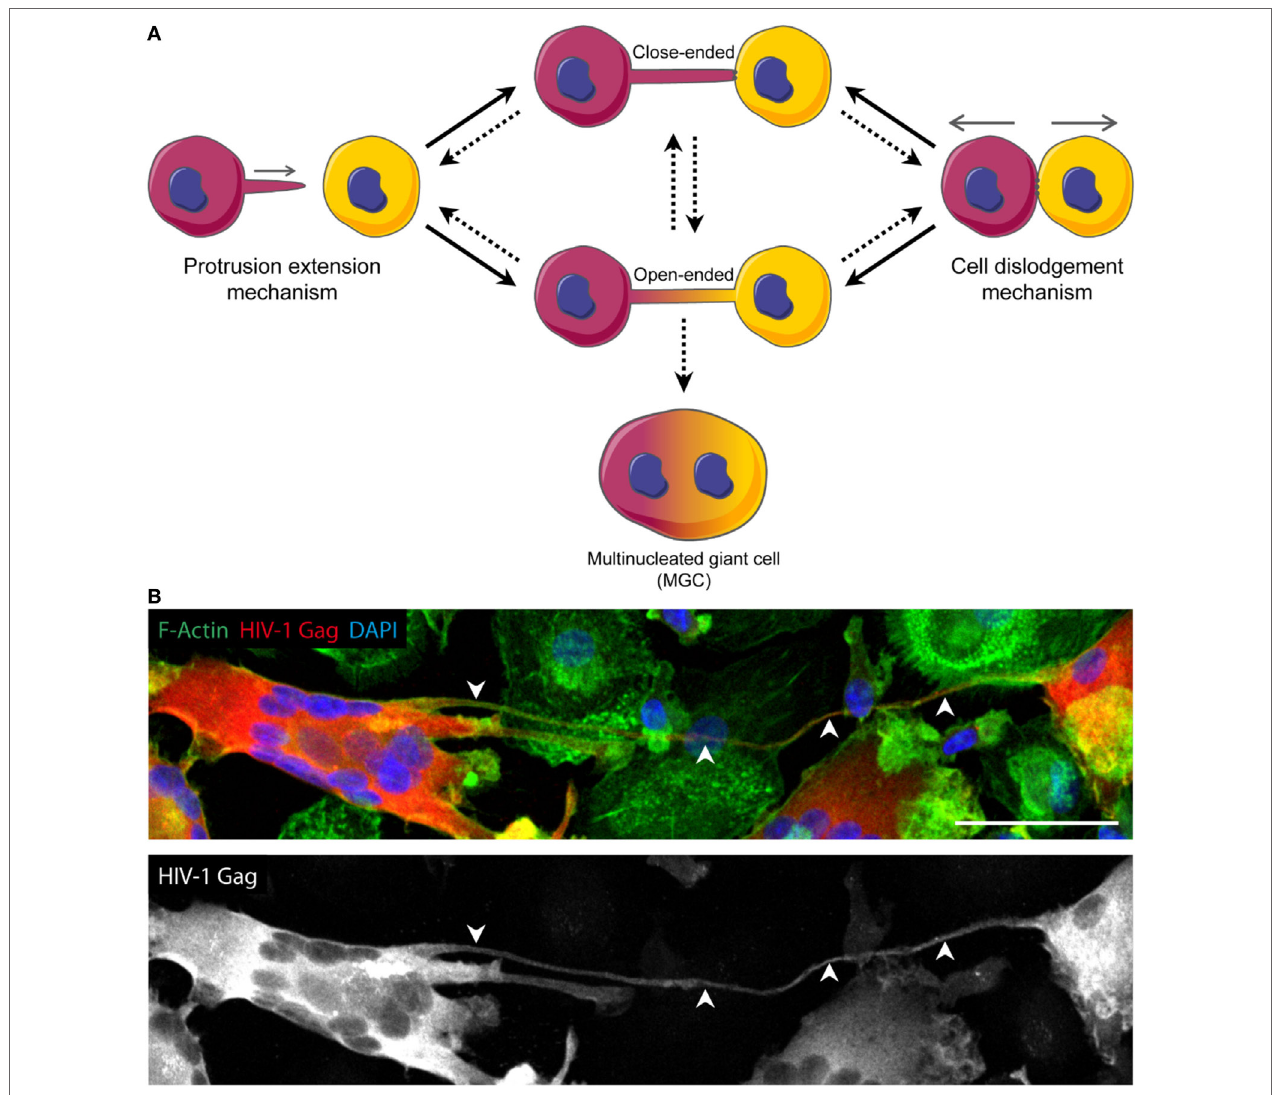
FigURe 1 | Models of tunneling nanotube (TNT) formation and putative role in the generation of multinucleated giant cells (MGC). (A) TNT can form according to two mechanisms: the “protrusion elongation” mechanism where the cell extends filopodia-like protrusion toward a specific target cell (left), and the “cell dislodgement” mechanism for which two cells initially in contact separate from each other, stuck by a thread of membrane that gives rise to a TNT (right). Each of these mechanisms can lead to either close-ended or open-ended TNT, the last one allowing cytoplasmic continuity between interconnected cells. The dynamics of close-ended and open-ended TNT formation is still not understood. In addition, TNT could either disconnect cells and thus abrogate their communication or could lead to MGC. (B) Confocal image of day 13 HIV-1-infected human monocyte-derived macrophages and MGC interconnected through a TNT. Arrowheads show a TNT. HIV-1 Gag (red), F-actin (green), DAPI (blue). Scale bar, 50 µm.